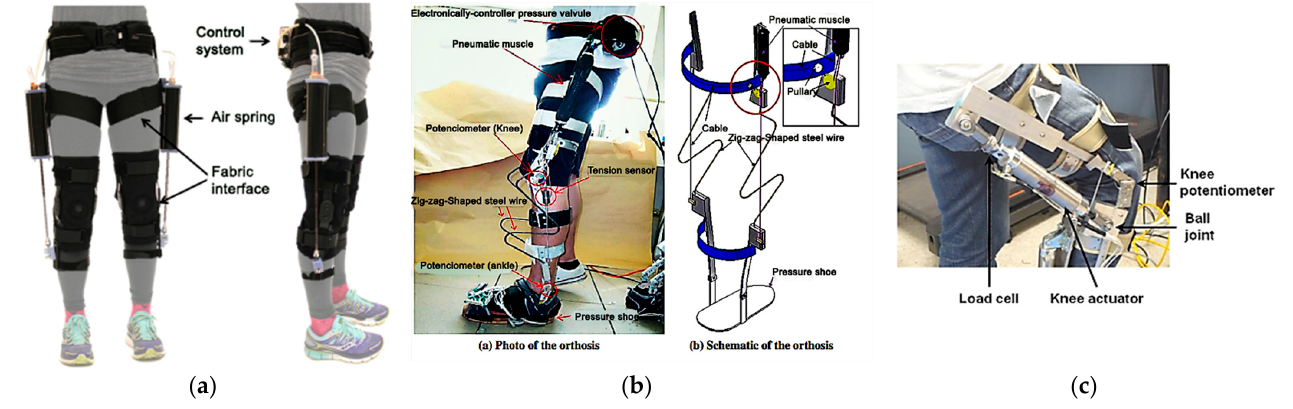
Figure 11. Knee orthosis with pneumatic actuator: ( a ) Rogers et al., 2017 [65], ( b ) yeh et al., 2018 [69], ( c ) Wu et al., 2012 [71].